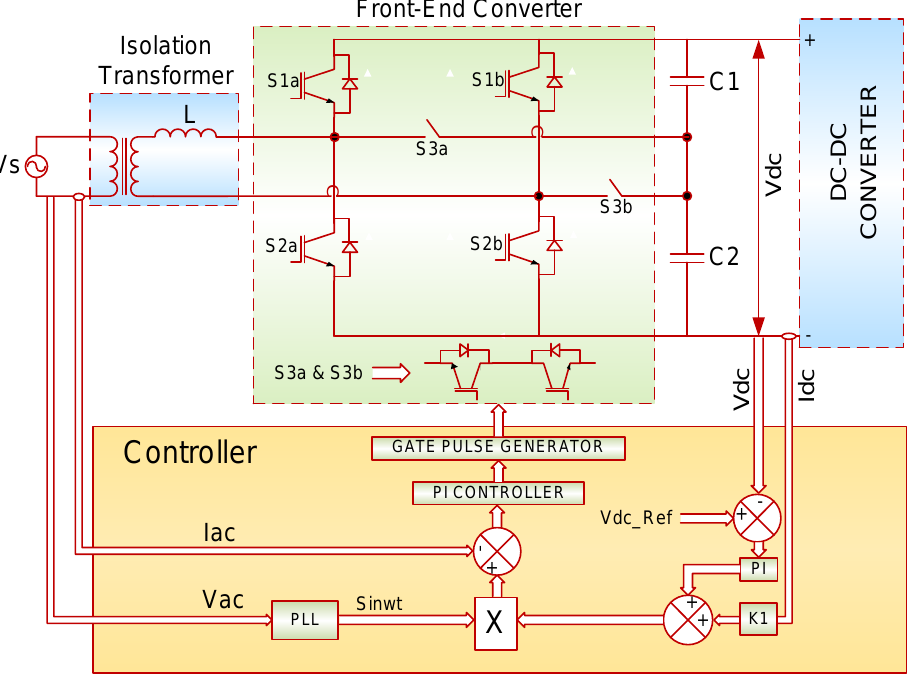
Figure 2. Control Block diagram of T-Type Front-End Converter.